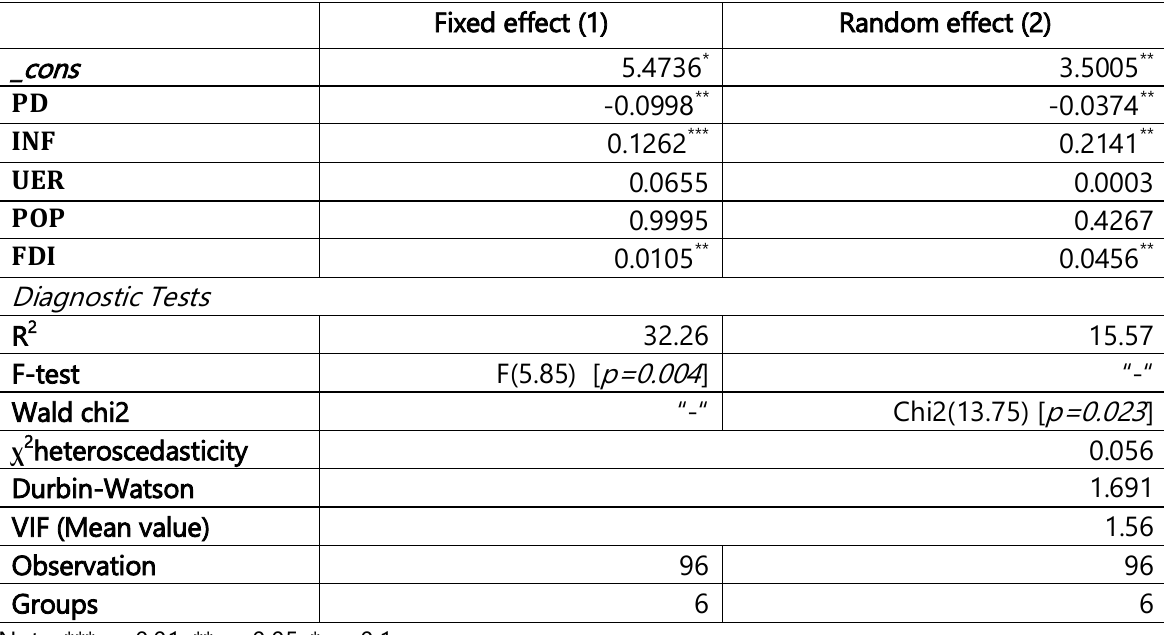
Table 5: Parameter Estimates (Source: Authors’